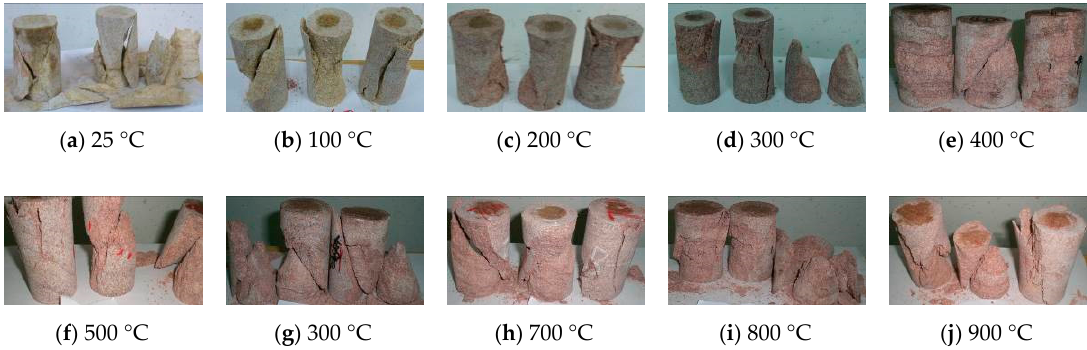
Figure 11. Uniaxial compression failure modes after high temperature.